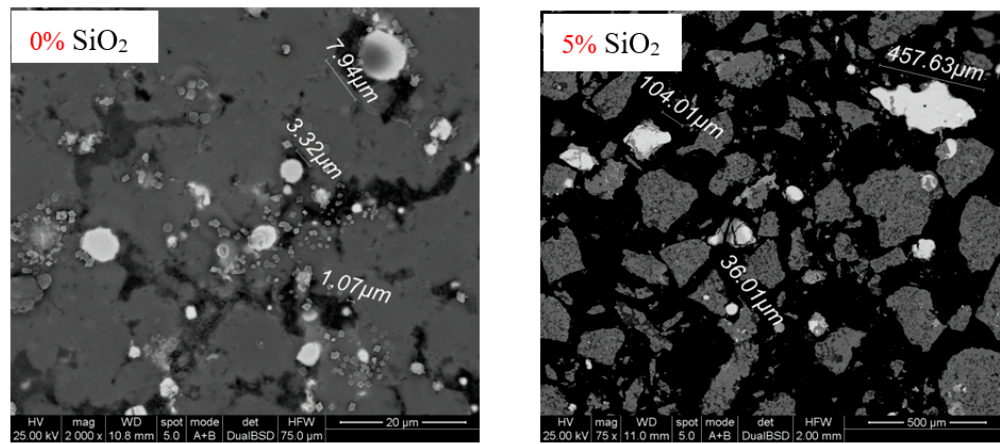
Figure 9. SEM image of the reduction calcines in 0% and 5% SiO 2.